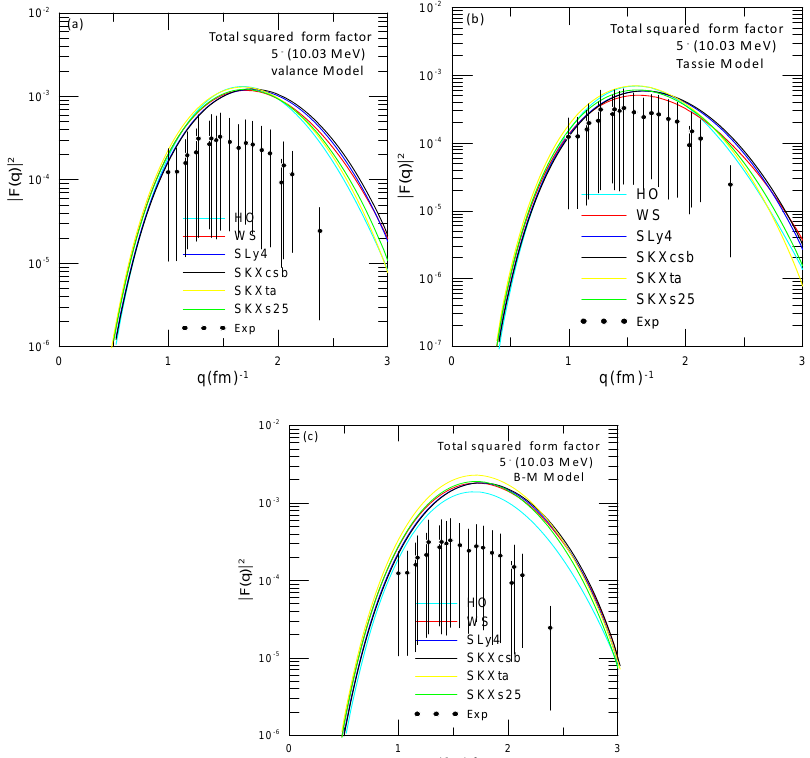
Fig. 10: Total squared form factors for the second 5 - , 10.03 MeV using different single particle potential compared with the experimental data taken from Ref. [6].